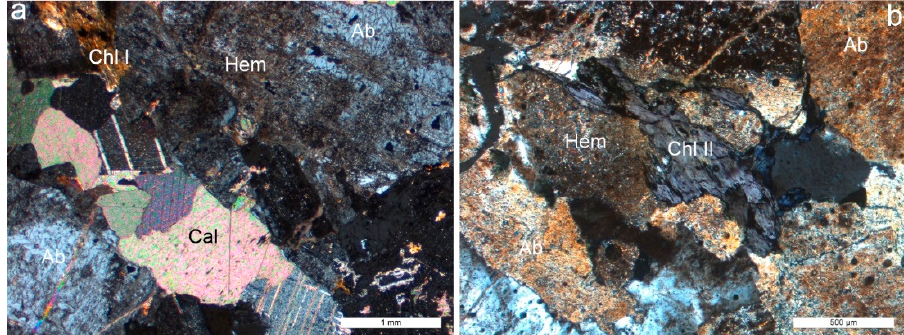
Figure 5. Microphotographs of hydrothermally altered granitoids (Ab—albite, Cal—calcite, Chl— chlorite, and Hem—hematite), ( a )—Nahošín uranium deposit, sample R-752; ( b )—Me č ichov uranium deposit, sample R-784. Calcite usually occur in small veins and veinlets. Albite is enriched by very fine hematite grains. Chlorite I originated by alteration of biotite. During post-ore stage originated sometimes chlorite II. Crossed polarizers.